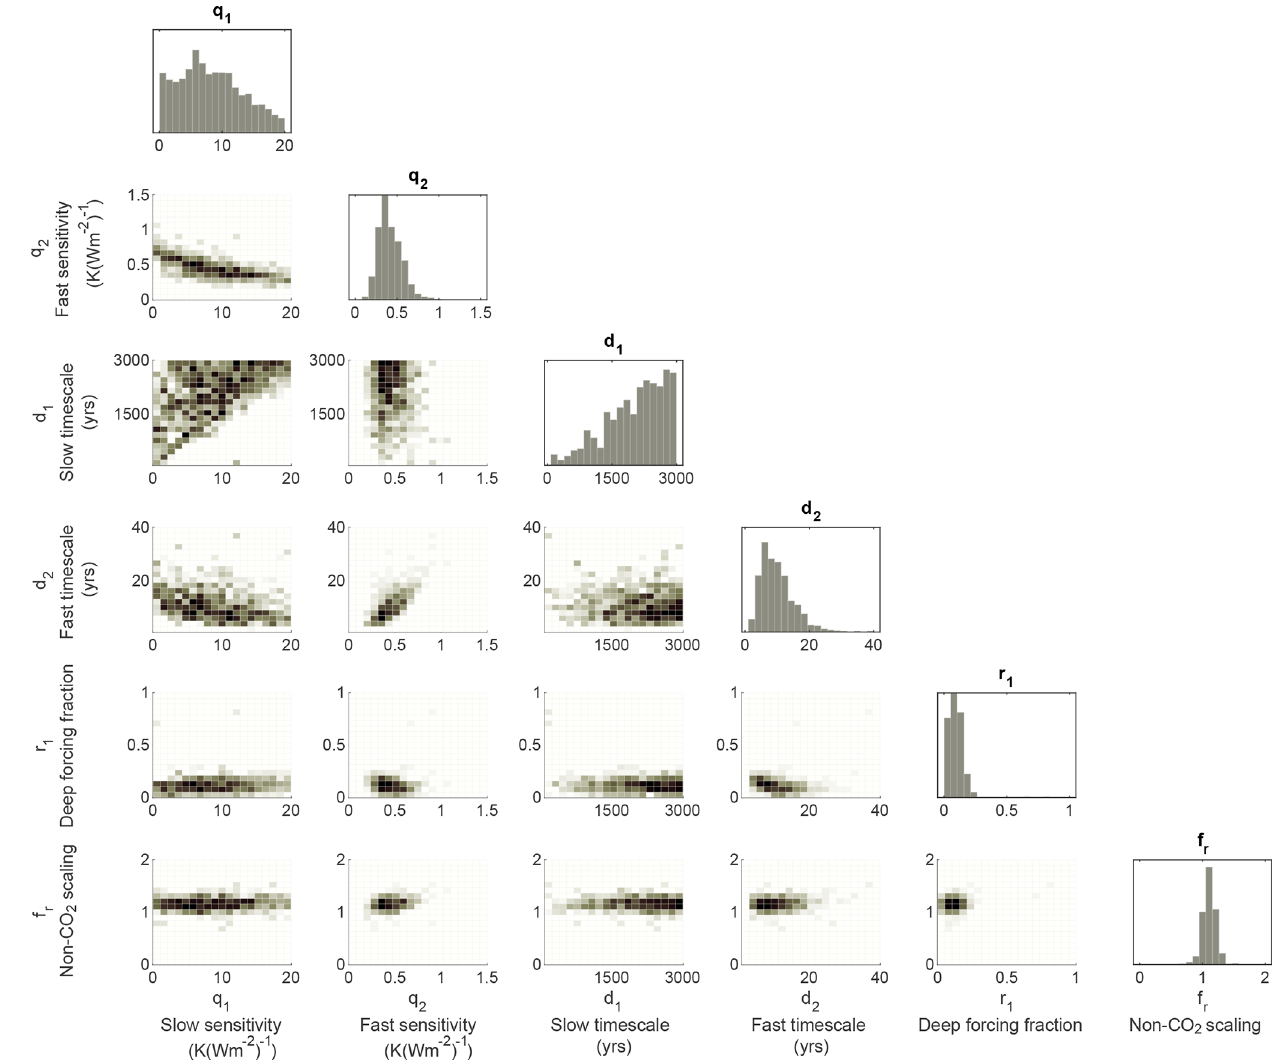
Figure 3. A “corner plot” showing the posterior parameter distribution attained by MCMC calibration of the simple climate model. Diagonal plots show posterior histograms for each of the parameter values optimized in the calibration, where the x -axis range reflects the bounding values of the initial flat prior distribution. Off-diagonal plots show pairwise distributions of parameters in the posterior